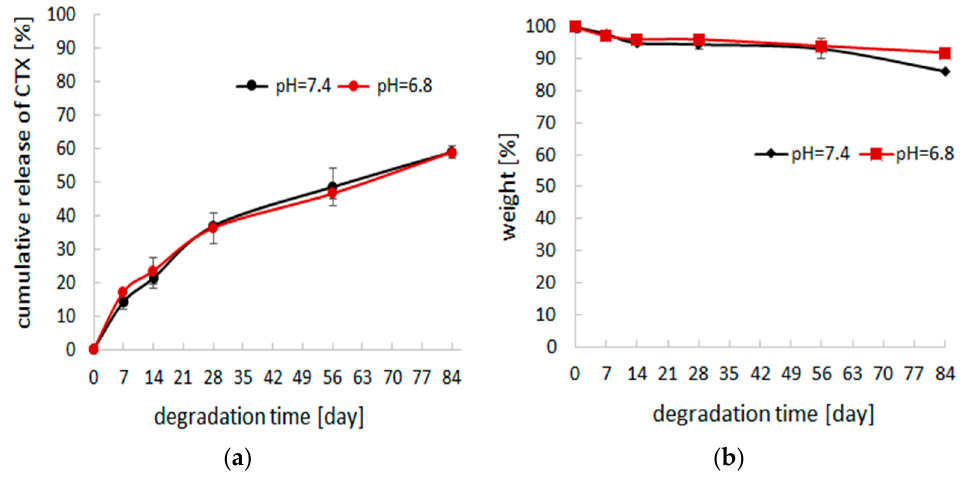
Figure 5. ( a ) cumulative release of CTX-loaded patches, (PGCL/PLGA) + CTX, during 84 days of incubation in PBS (pH = 7.4 and pH = 6.8), (n = 3); ( b ) weight changes during degradation of PGCL/PLGA) + CTX patches in PBS (pH = 7.4 and pH = 6.8), (n = 3). PGCL/PLGA) + CTX patches in PBS (pH = 7.4 and pH = 6.8), (n = 3).